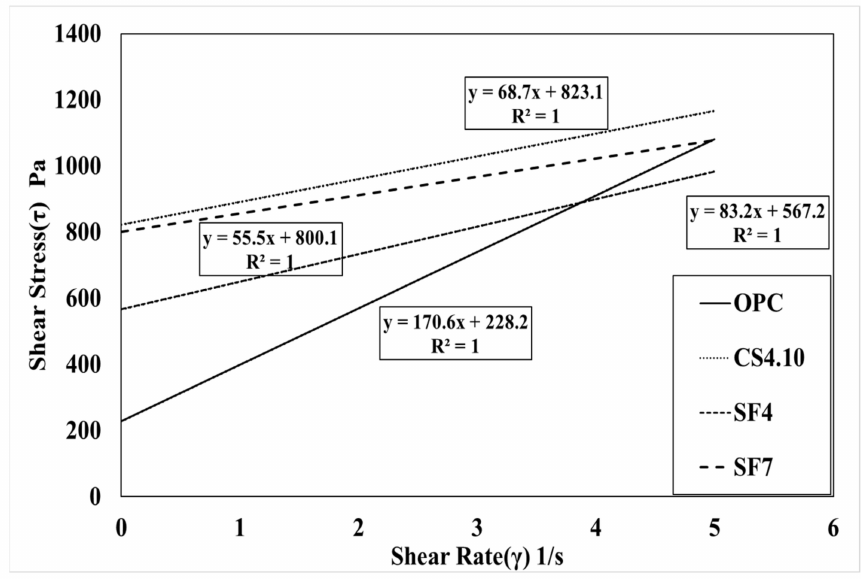
Figure 10. Bingham model results according to the mixing ratio of silica fume and colloidal